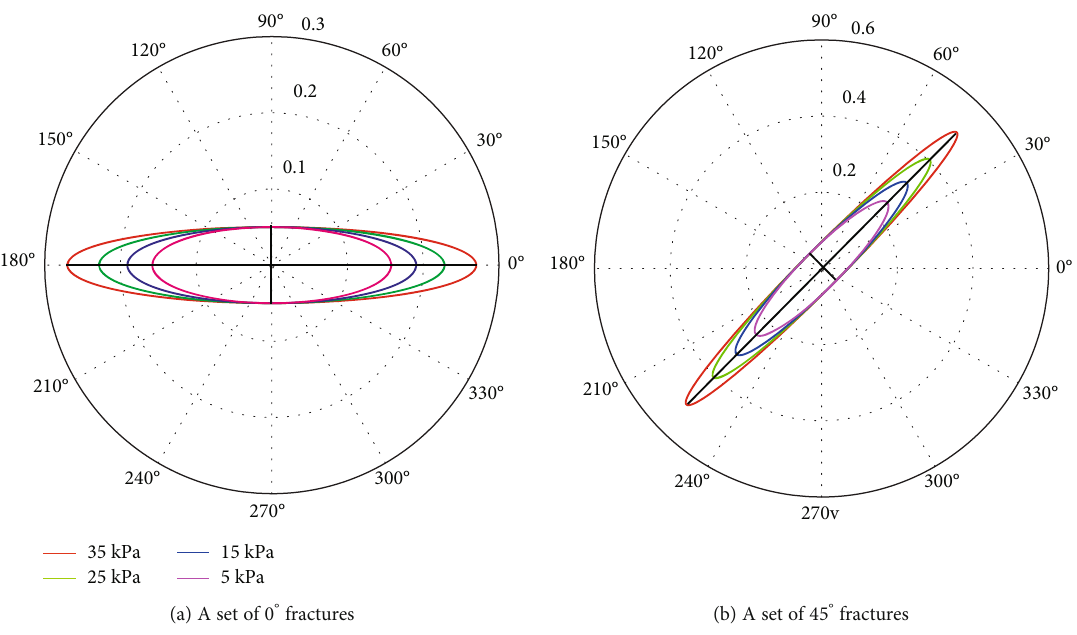
Figure 20: Anisotropic permeability tensor as a function of fl uid